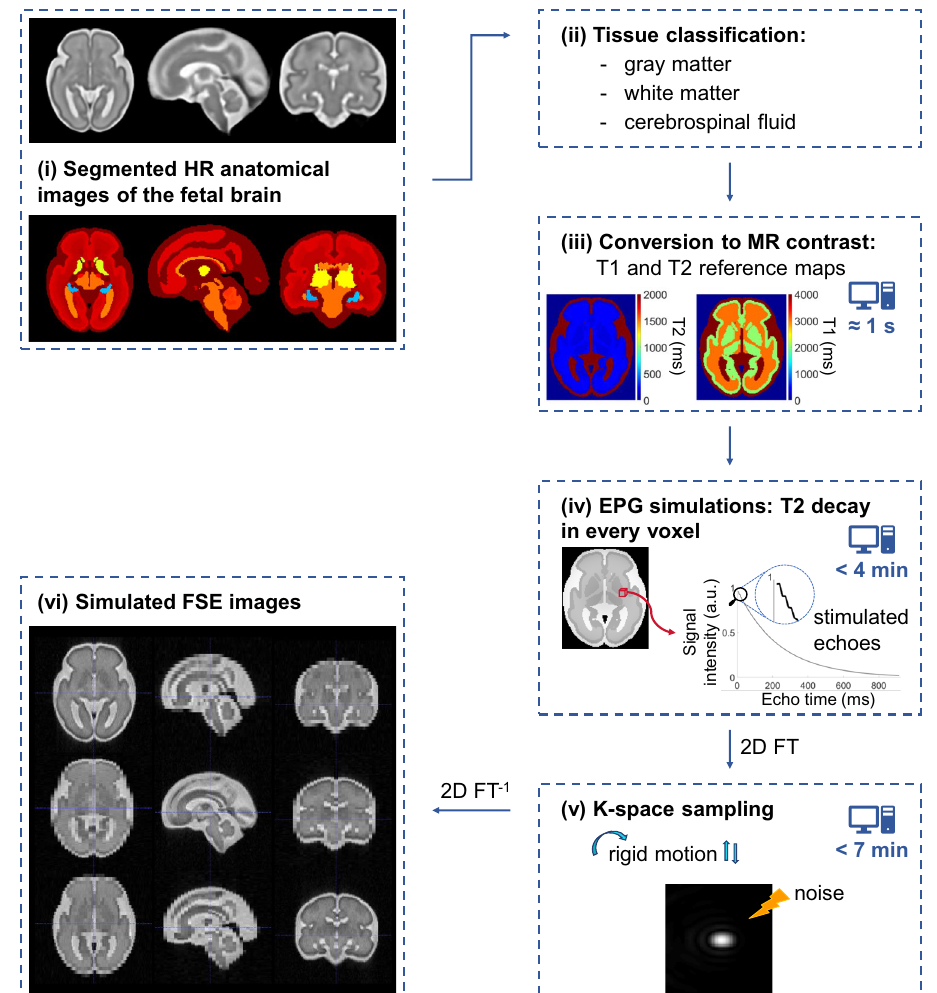
Figure 1. Workflow for simulating images of the fetal brain acquired by a fast spin echo (FSE) sequence ( i ) from segmented HR anatomical MR images 10 , illustrated for a fetus of 30 weeks of GA. ( ii ) Brain tissues are classified into gray matter, white matter and cerebrospinal fluid. ( iii ) Anatomical structures are converted to the corresponding MR contrast to obtain reference T1 and T2 maps of the fetal brain at either 1.5 or 3 T. ( iv ) The EPG algorithm allows to accurately simulate the T2 decay over time in every brain voxel by accounting for the effects of the stimulated echoes, as highlighted by the enlargement of the beginning of the curve. This spatiotemporal information is subsequently used ( v ) to sample the Fourier domain of the simulated images of the moving fetus. After the addition of noise to match the SNR of real clinical acquisitions, ( vi ) FSE images of − 1 the fetal brain are eventually recovered by 2D inverse Fourier transform (2 D FT